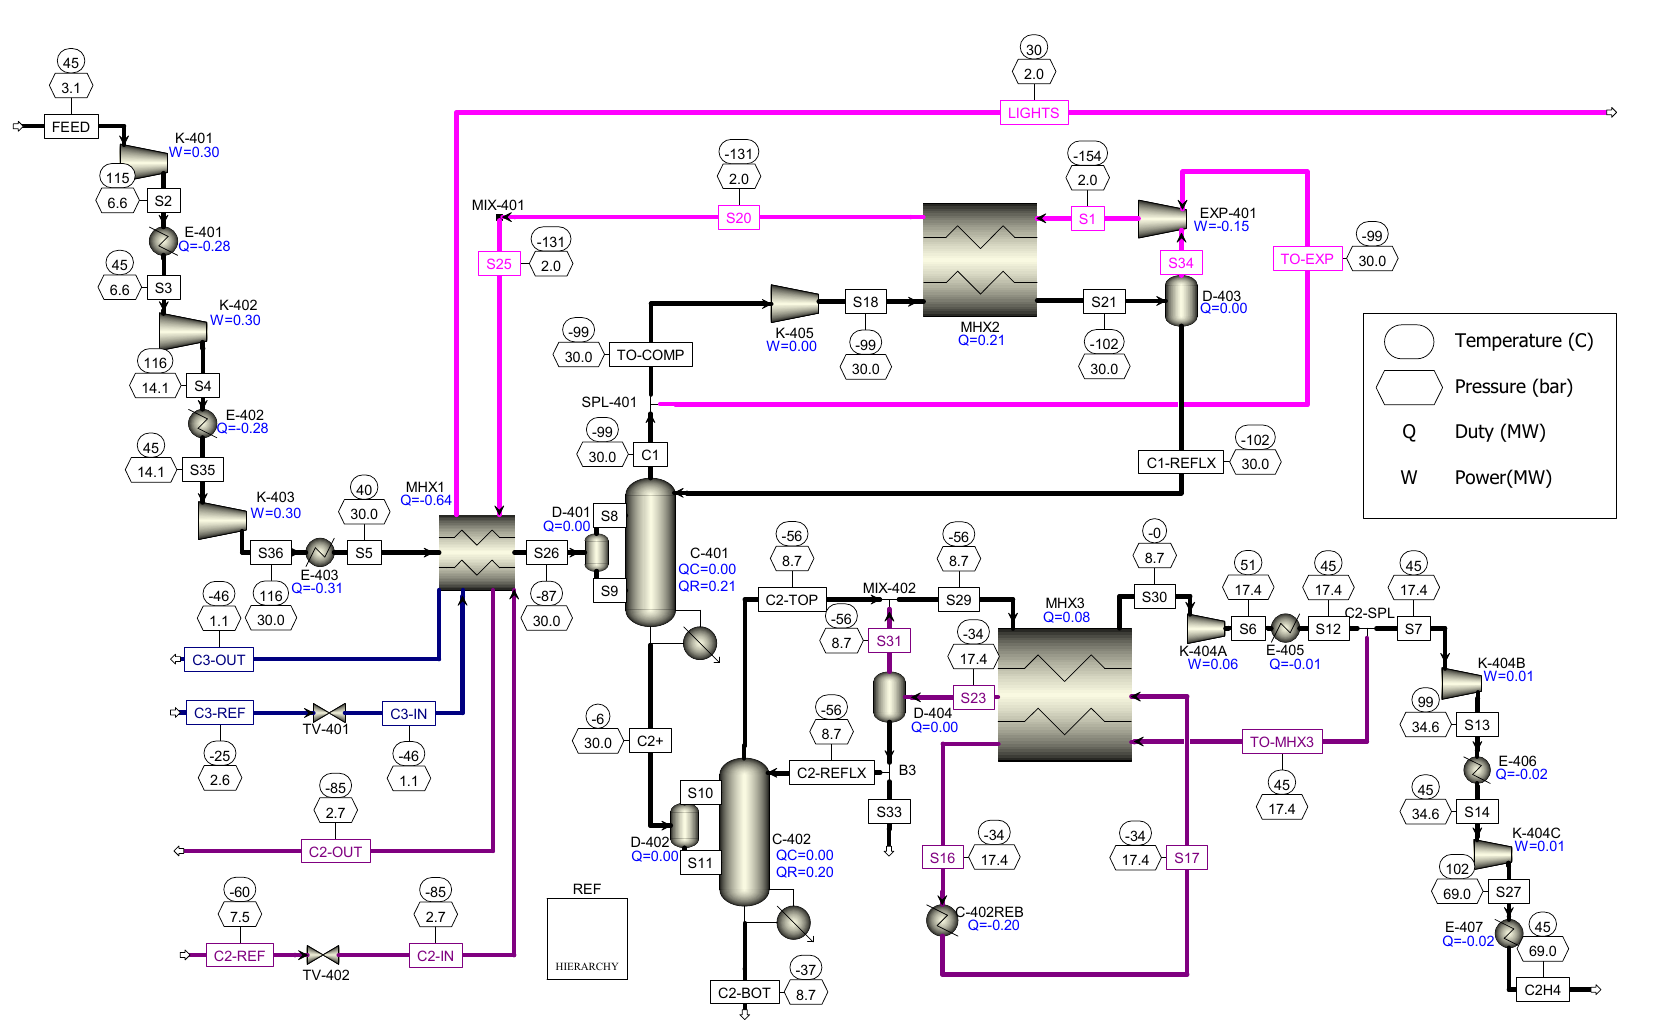
Figure 11. Process simulation of the RSV distillation configuration implemented in Aspen Plus software. Reproduced with permission from Penteado, Ph.D. Thesis, TUB, 2021